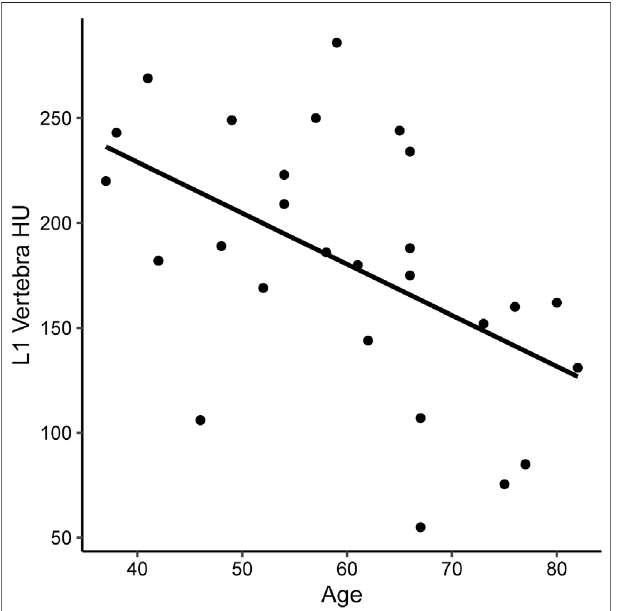
FIGURE3| Boxplots ofL1density (HU)byDXA classi fi cation; diamonds indicate the mean HU. FIGURE 2 | Scatterplot of CT-derived bone density [measures in